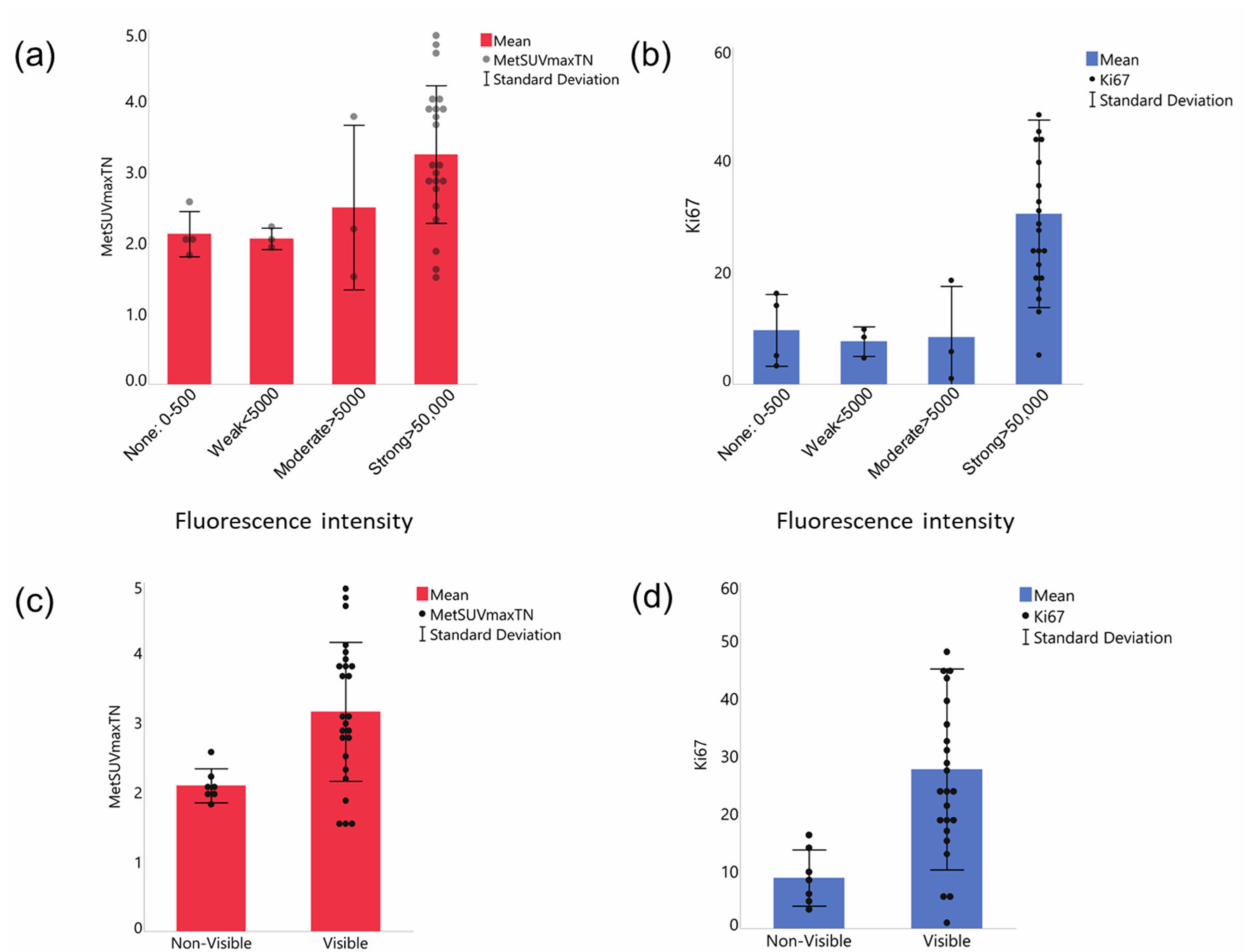
Figure 3. Relationships between MET-PET uptake and Ki-67 index versus quantified 5-ALA-induced fluorescence intensity. ( a , b ) Comparison between 4 fluorescence intensity groups. Both MET-PET ( a ) and Ki-67 index ( b ) were the highest in the strong fluorescence group. The one way ANOVA test revealed that the means of the 4 groups are not equal for both Ki-67 index and MET-PET uptake. However, the Tukey method’s posthoc analysis found no statistical significance in any pair. ( c , d ) Comparison of two fluorescence intensity groups rearranged based on signal visibility, Visible (including Strong and Moderate groups) or Non-visible (Weak and None), for MET-PET uptake ( c ) and Ki-67 index ( d ). Unpaired t tests were significant for MET-PET uptake ( c , p < 0.001) and Ki-67 ( d , 0.0091). The data are shown by means (solid bars) and standard deviation (error bars), with each dot representing a